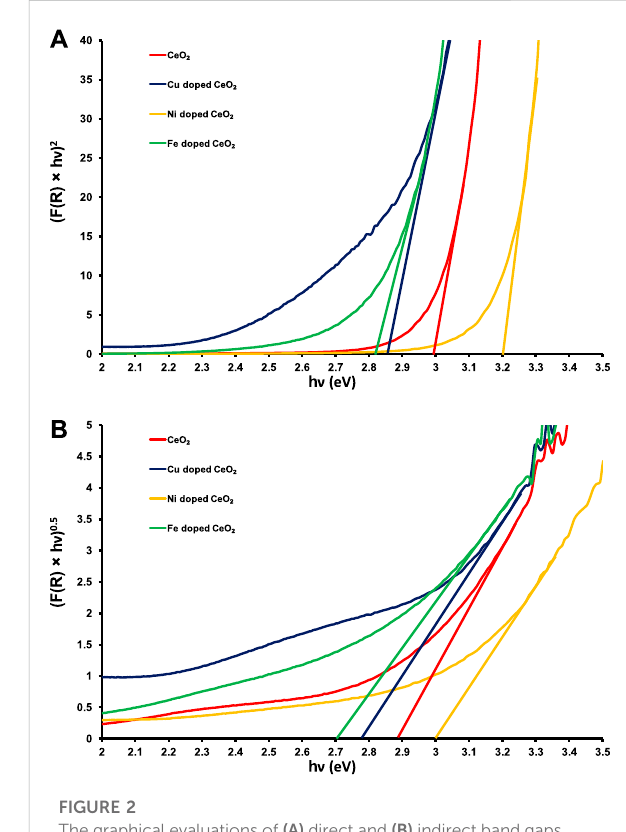
FIGURE 2 The graphical evaluations of (A) direct and (B) indirect band gaps of pristine and doped CeO 2